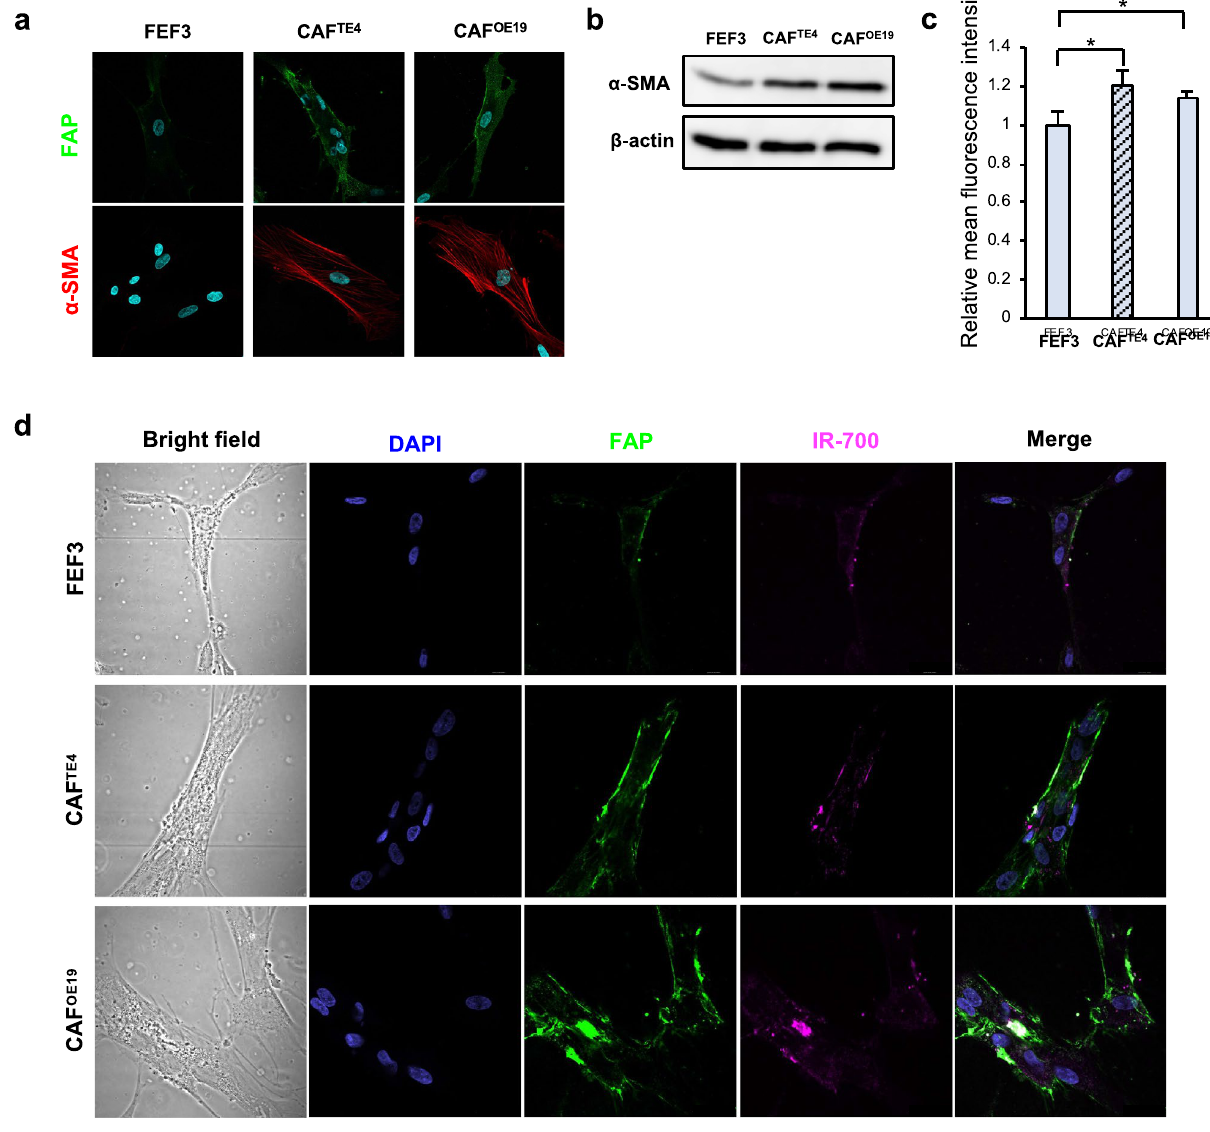
Figure 4. FAP expression in CAFs and conjugation of FAP-IR700. ( a ) Immunofluorescence imaging of fibroblasts is shown. Normal FEF3 cells did not express FAP or αSMA, while CAFs stimulated with tumor cells expressed FAP on the cell surface and αSMA in the cytoplasm. Images are shown at 600 × magnification (green: FAP, red: αSMA, blue: nucleus). ( b ) WB demonstrated that the expression of αSMA was increased in CAFs compared to untreated FEF3 cells. ( c ) Flow cytometry demonstrated the expression of FAP. The relative mean fluorescence intensity of FAP was significantly increased in CAFs compared to untreated FEF3 cells as found by our FlowJo Software. Data are shown as the mean ± SD, Student’s t test. ** P < 0.05. ( d ) The binding of FAP on CAFs and FAP-IR700 is shown by immunofluorescence imaging. After 6 h of conjugation with FAP-IR700, fibroblasts were fixed and observed by confocal microscopy. IR700 was observed in the same location as FAP expression in CAFs. However, it was not observed in normal FEF3 cells. Images are shown at 600 × magnification (green: FAP, blue: nucleus, magenta: